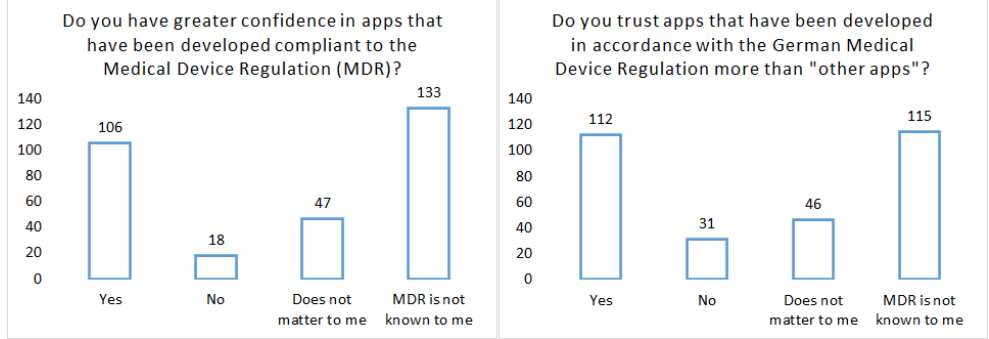
Figure 4. Corona Health COMPASS